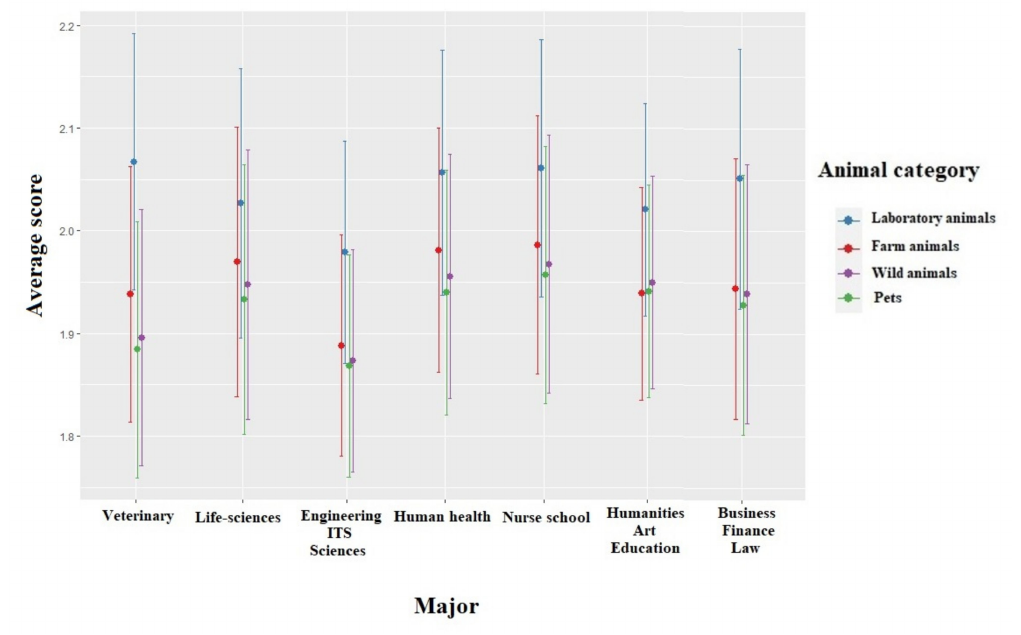
Figure 5. Means and 95% confidence intervals of scores towards the Five Freedoms model depending on the students’ major and the animal class. Means have been back-transformed from a log scale but 95% confidence intervals are presented on the log